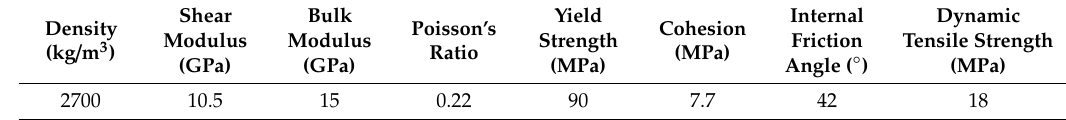
Table 3. Parameters of the explosives and JWL equation.